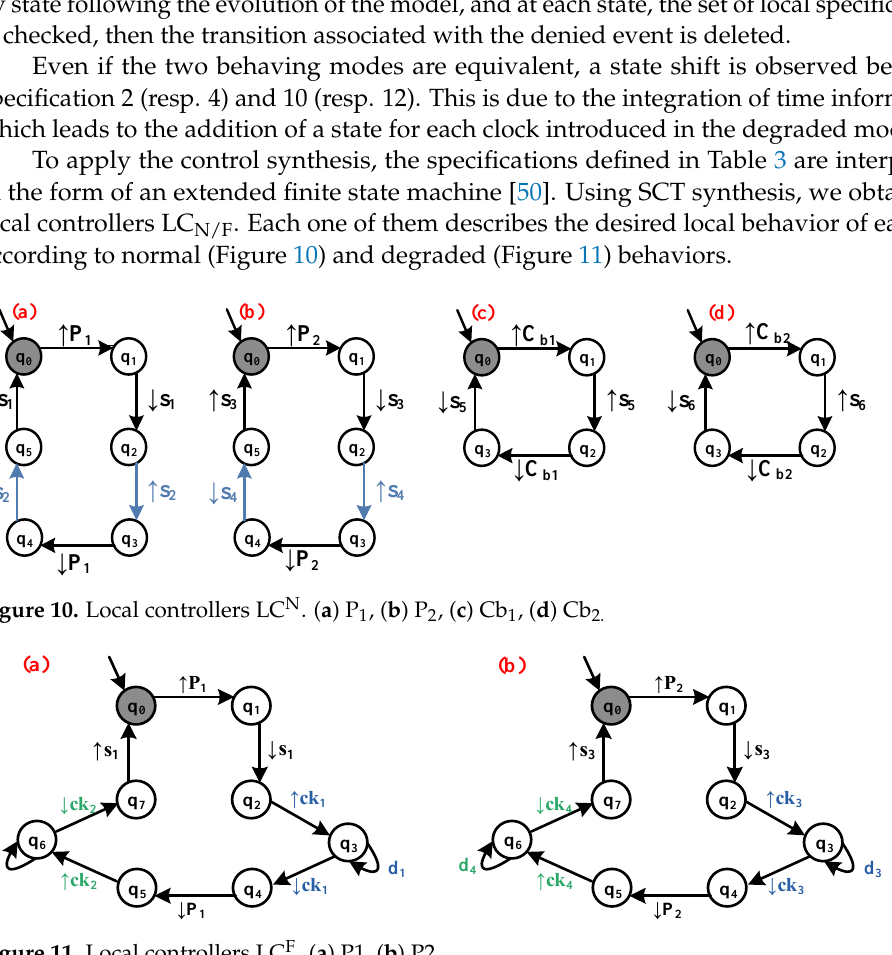
Table 4. Set of global specifications.